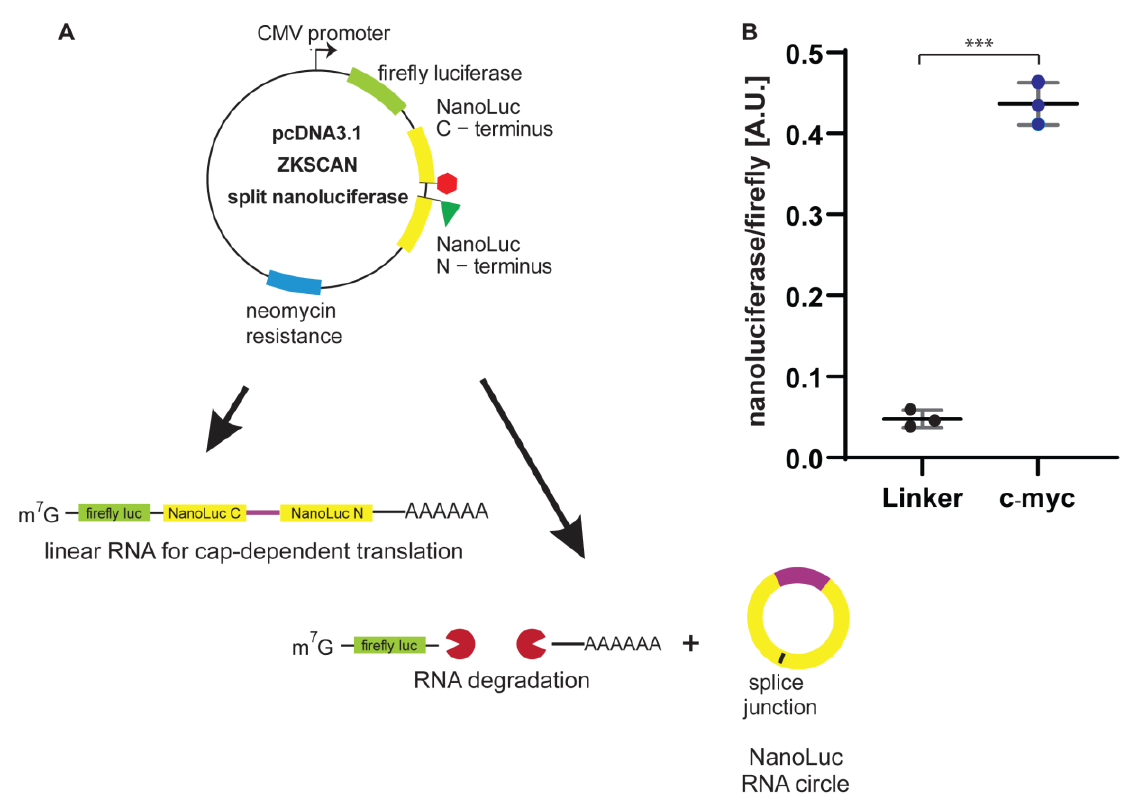
Figure 3. A split NanoLuc reporter plasmid with a firefly luciferase reporter as an internal control. ( A ) Schematic of the split NanoLuc reporter plasmid with the firefly luciferase inserted into the MCS of pcDN3.1. Upon transcription, the linear RNA contains both the firefly luciferase open reading sequence and the split NanoLuc ORF. The linear RNA yields active firefly luciferase protein, while the split NanoLuc protein remains inactive. Upon backsplicing, the NanoLuc ORF remains in the circular RNA, is fused and yields NanoLuc protein. ( B ) NanoLuc over firefly luciferase values is plotted for the linker control and the c-Myc cellular IRES. Experiments were performed in triplicate. Error bars represent the standard deviation. Significances were calculated using an unpaired t test with Welch’s correction with p ≤ 0.001 = *** .